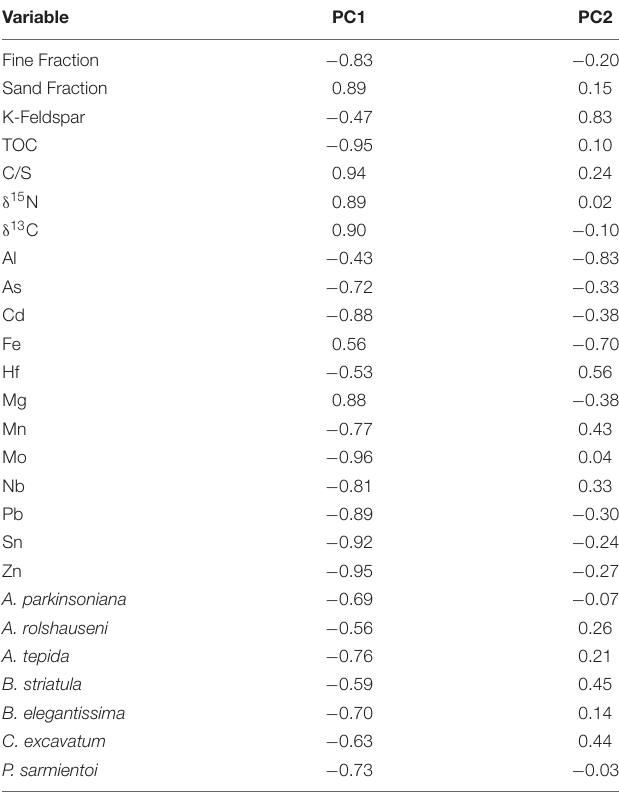
TABLE 3 | Correlations between factors and variables (factor loadings) based on the inverse matrix (product-moment/Pearson).